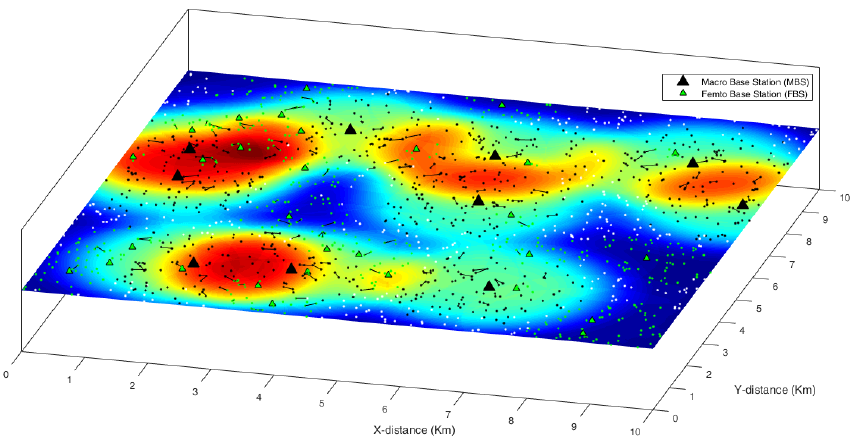
Figure 3. Coverage simulations for the proposed spectrum-aware D2D-enabled HetNet. The D2D connections are shown by solid black lines. The green and black points, respectively, represent the users connected to the femto base stations (FBSs) and macro base stations (MBSs). The white points are inactive users.